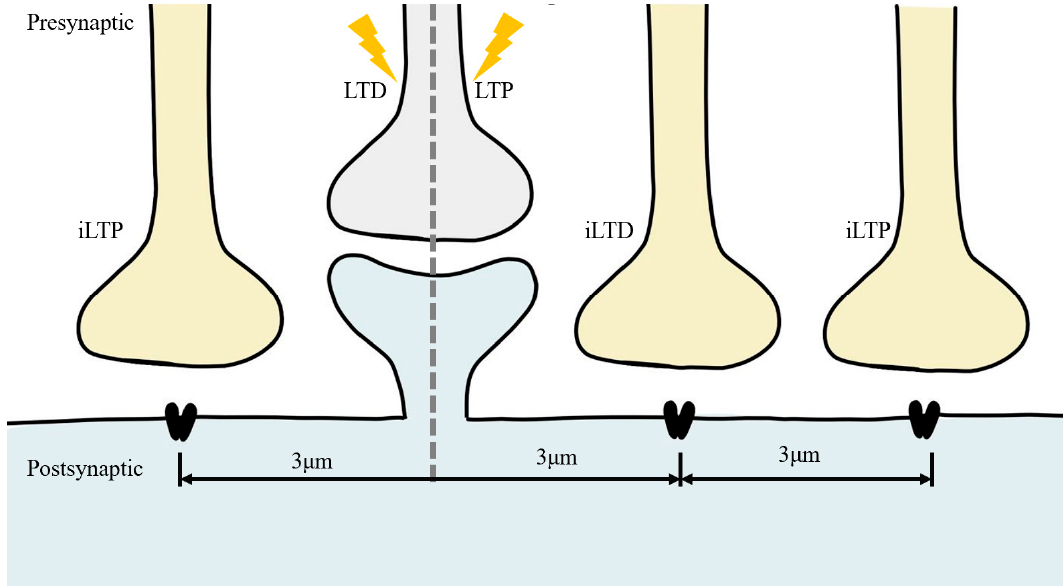
Figure 3. Coordinated plasticity of excitatory and inhibitory synapses [55]. LTP induction at a single glutamatergic spine leads to inhibition of nearby GABAergic inhibitory synapses (<3 µm, iLTD), while more distant synapses are enhanced (>3 µm, iLTP), and such GABA_iLTP is